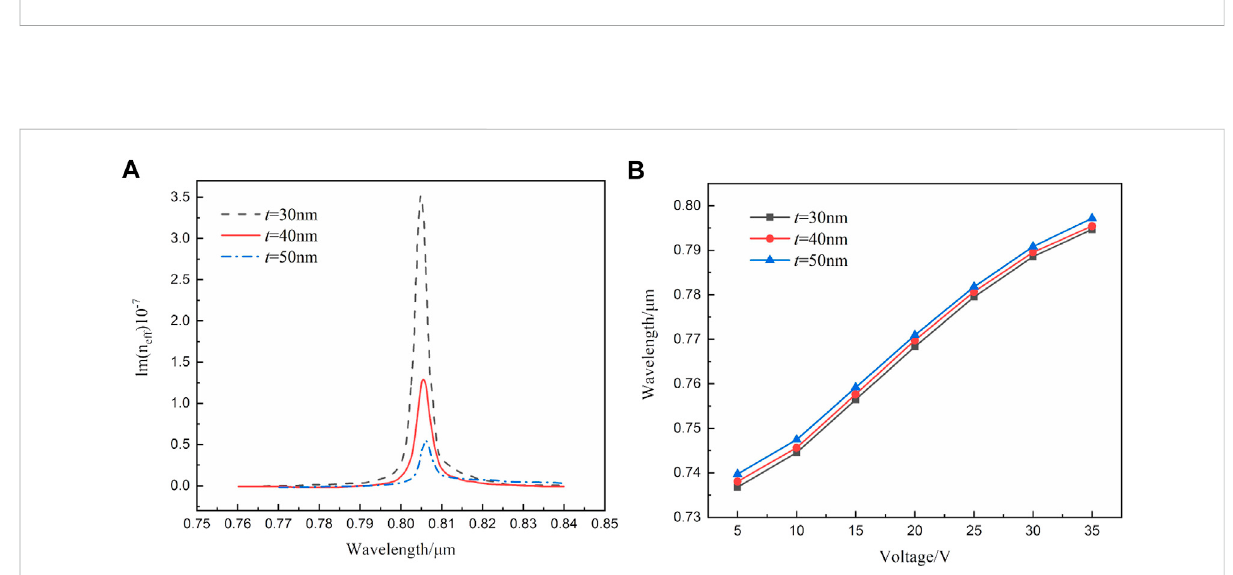
FIGURE 5 In fl uenceofdifferentairholediameter d onsensingcharacteristicsunderSPReffectbysetting N =3, Λ =8 μ m, t =40 nm. (A) Thelosscurvesof core mode for different d. (B) The resonance wavelength with voltage for different